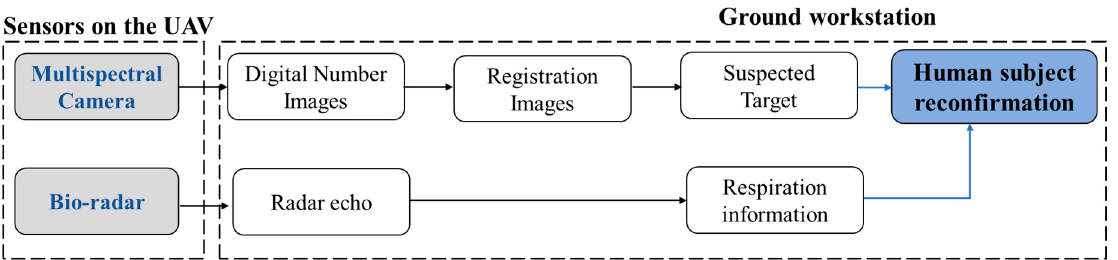
Figure 2. The diagram of the bimodal information collection system.